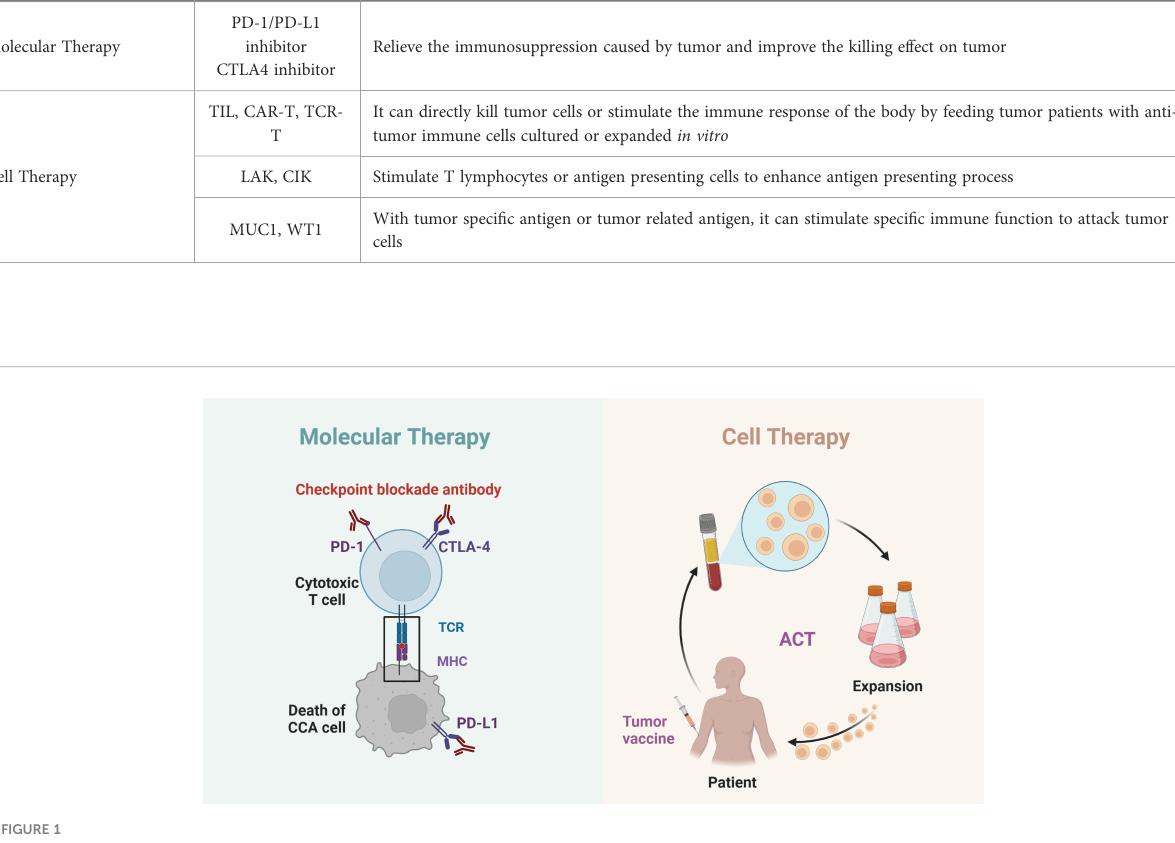
TABLE 2 Some immunotherapeutic strategies currently used in clinical trials to treat CCA. Immunotherapeutic